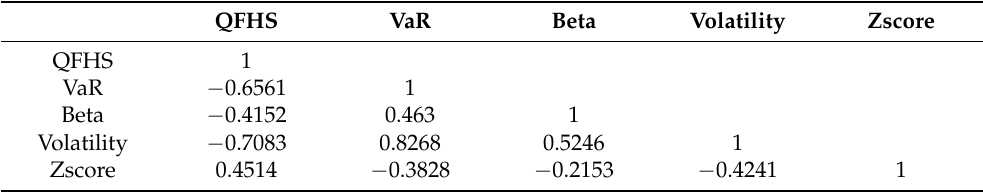
Table 2. Correlation matrix between the different risk